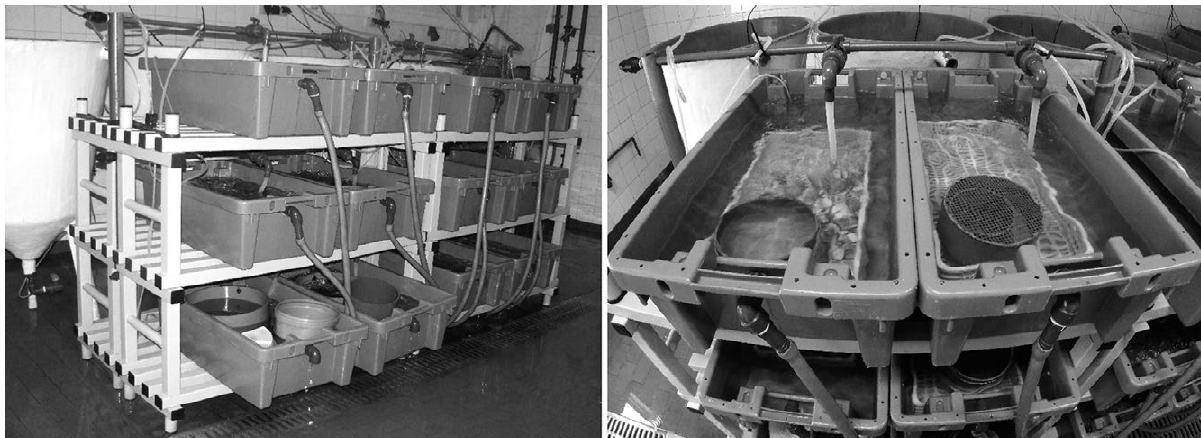
Fig. 2. – General overview of the containment facilities (flow-through system) where the survival experiments were performed in the Mol- luscan Aquaculture Experimental Station of